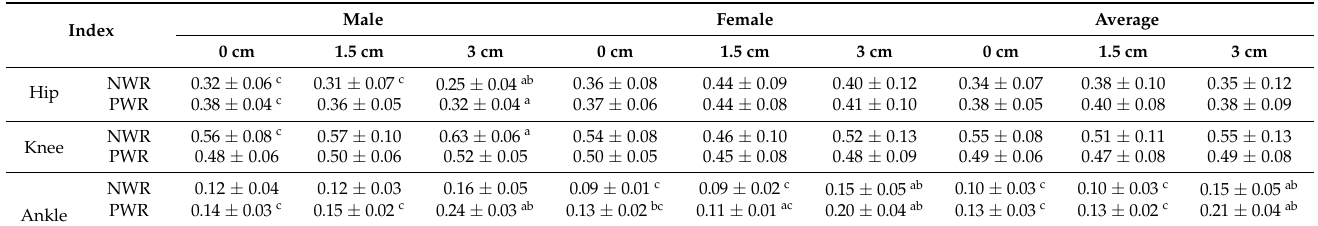
Table 3. The relative proportion of work done by